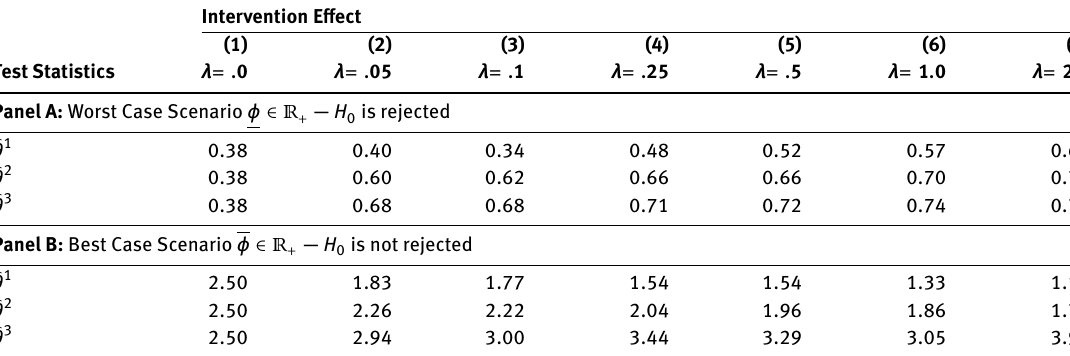
Table 3: Sensitivity